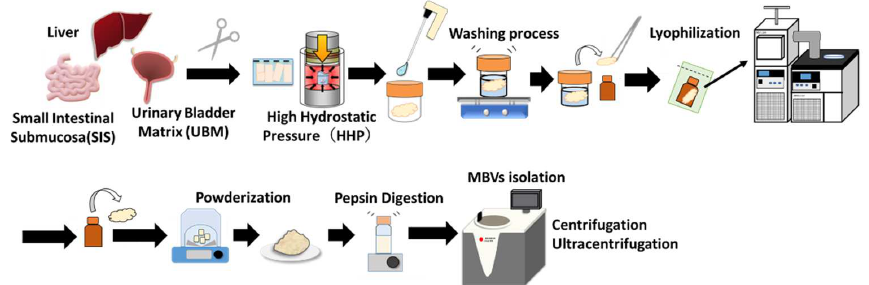
Figure 9. Schematic illustration of the preparation of MBVs derived from porcine-decellularized tissues.